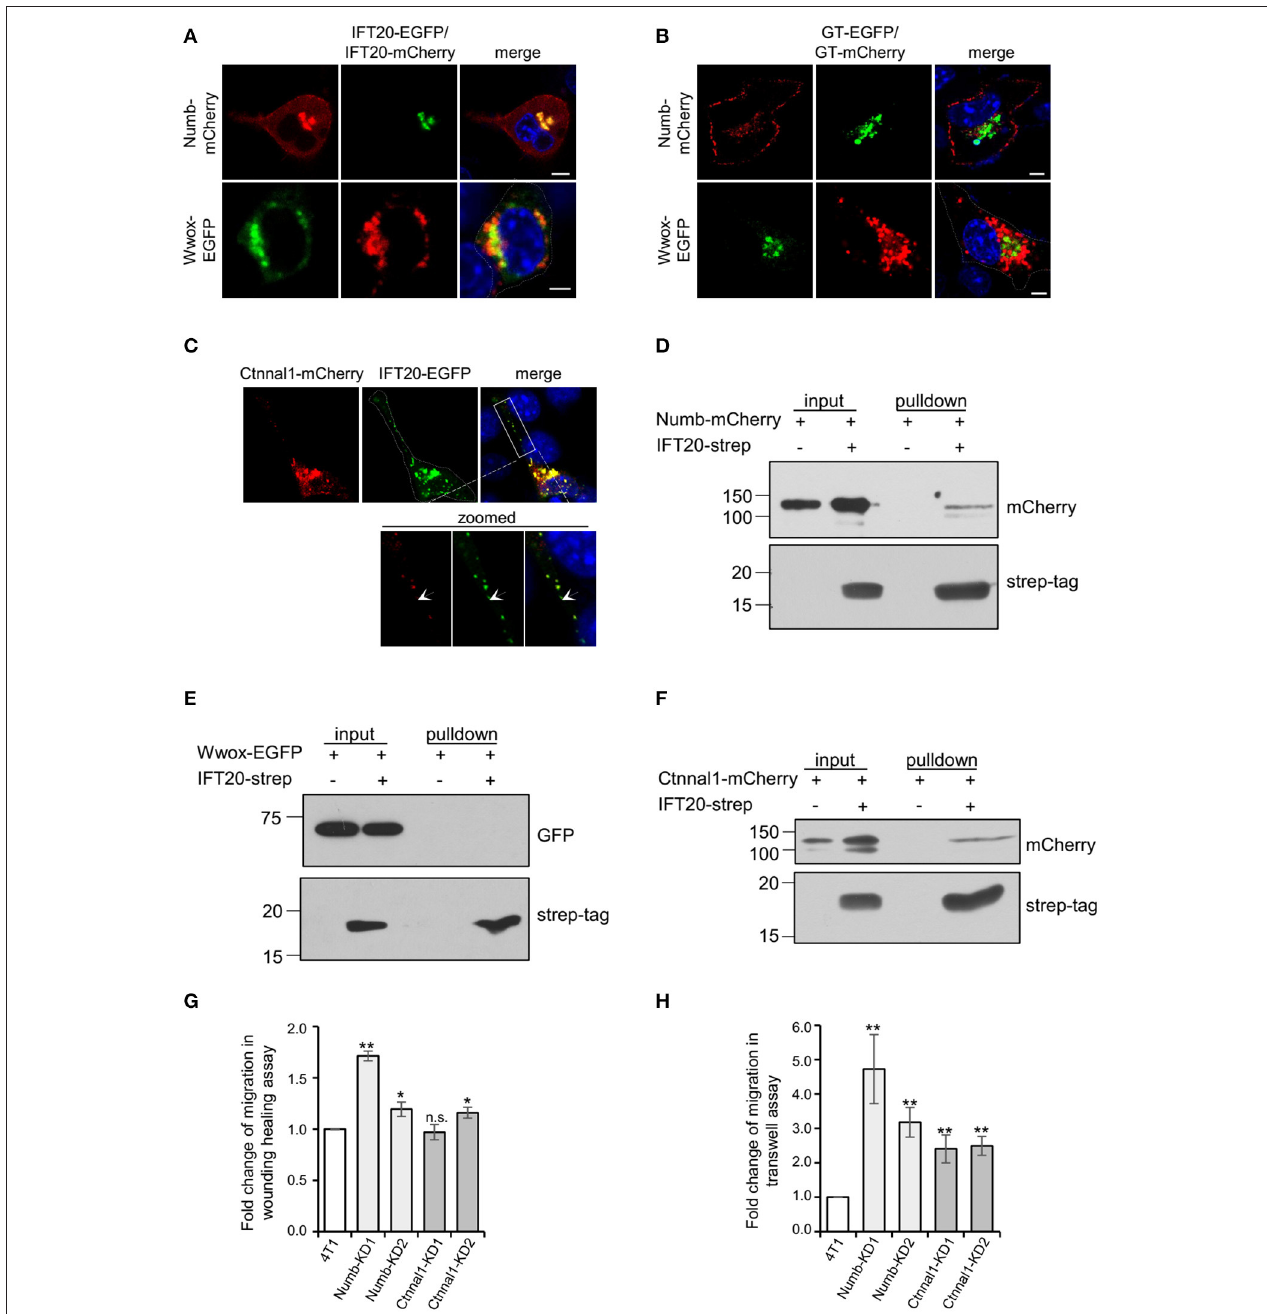
FIGURE 7 | IFT20 is involved in transport Numb and Ctnnal1 from the TGN to the plasma membrane. (A) Representative fluorescent images of 4T1 cells co-expressing IFT20-EGFP/mCherry and Numb-mCherry or Wwox-EGFP showing that IFT20 colocalized with Numb and scarcely colocalized with Wwox at the perinuclear region. (B) The respective distribution of GT-EGFP/GT-mCherry and Numb-mCherry or Wwox-EGFP showed that the perinuclear localization of Numb was trans-Golgi/TGN and Wwox localized at the cis-Golgi. (C) Representative fluorescent images of 4T1 cells co-expressing IFT20-EGFP and Ctnnal1-mCherry showed that IFT20 colocalized with Ctnnal1 not only at the Golgi, but also in the intracellular vesicles. The white dotted line marks the entire cell profile. The white dashed rectangular box marks the zoomed images on the bottom. (D–F) Strep-pulldown assay of IFT20-Strep and Numb-mCherry (D) , EGFP-Wwox (E) , or Ctnnal1-mCherry (F) . HEK293T cells were transfected with plasmids that express Numb-mCherry (D) , EGFP-Wwox (E) , or Ctnnal1-mCherry (F) combined with or without IFT20-Strep expression plasmid. After 24h, the cells were lysed and centrifuged. The supernatants (input) were incubated with Strep-Tactin beads, and the proteins bound to the beads (pulldown) were analyzed by Western blot using anti-Strep tag or anti-mCherry/EGFP antibodies. (G,H) Quantification of the migration efficiency in the wound healing assay (G) and transwell assay (H) ; results showed that knockdown of Numb and Ctnnal1 enhanced breast cancer cell migration. All quantifications were carried out in three independent experiments, and data are expressed as the mean ± S.D.; n.s. (not significant) p > 0.05; * p ≤ 0.05; ** p ≤ 0.01. All fluorescent experiments were performed three times. The nucleus is stained by DAPI (blue); scale bar, 5 µ m.